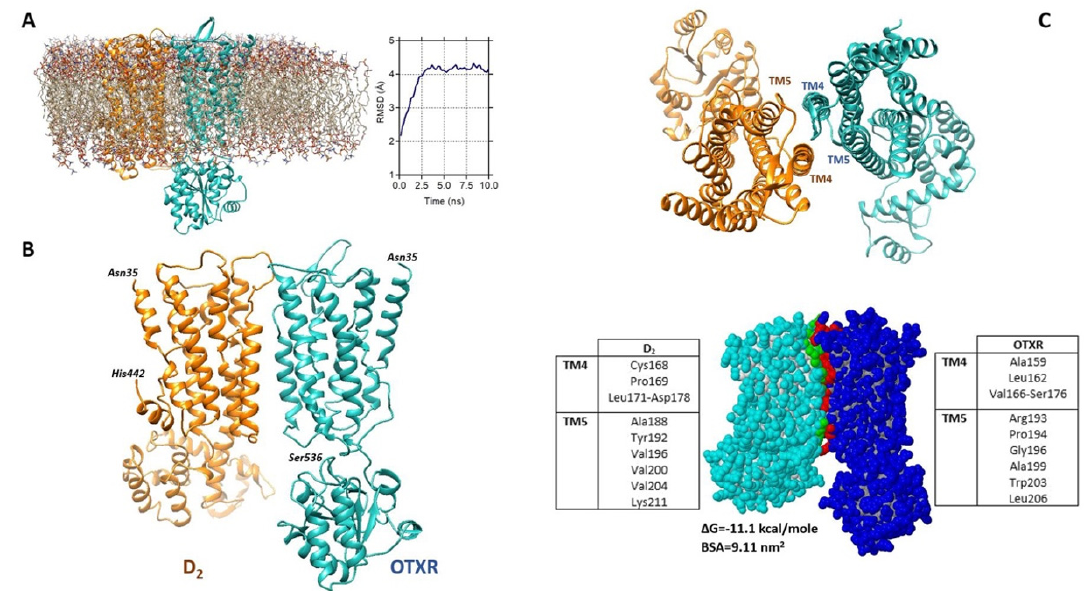
Figure 7. Estimated model of the D2-OTR heterodimer. ( A ) The heterodimeric structure of D 2 and OTR, as obtained by docking, is shown in the environment used for Molecular Dynamics, including a 1-palmitoyl-2-oleoylphosphatidylcholine (POPC) lipid bilayer, ions (sodium and chloride, 0.15 M), and water molecules (not shown). The RMSD trajectory during the production phase is also shown. ( B ) Heterodimeric complex between D 2 and OTR as predicted by the computational procedure used. ( C ) In the upper panel the extracellular side of the estimated heteromeric structure is shown to indicate the TM4 and TM5 domains. The interface between D 2 and OTR is illustrated in the bottom panel together with the residues mainly involved in its formation. The ∆ G for complex formation and the interface area (buried surface area, BSA), as predicted by PDBePISA, are also reported. OTR, oxytocin receptor; RMSD, root mean square deviation; TM, transmembrane domains.